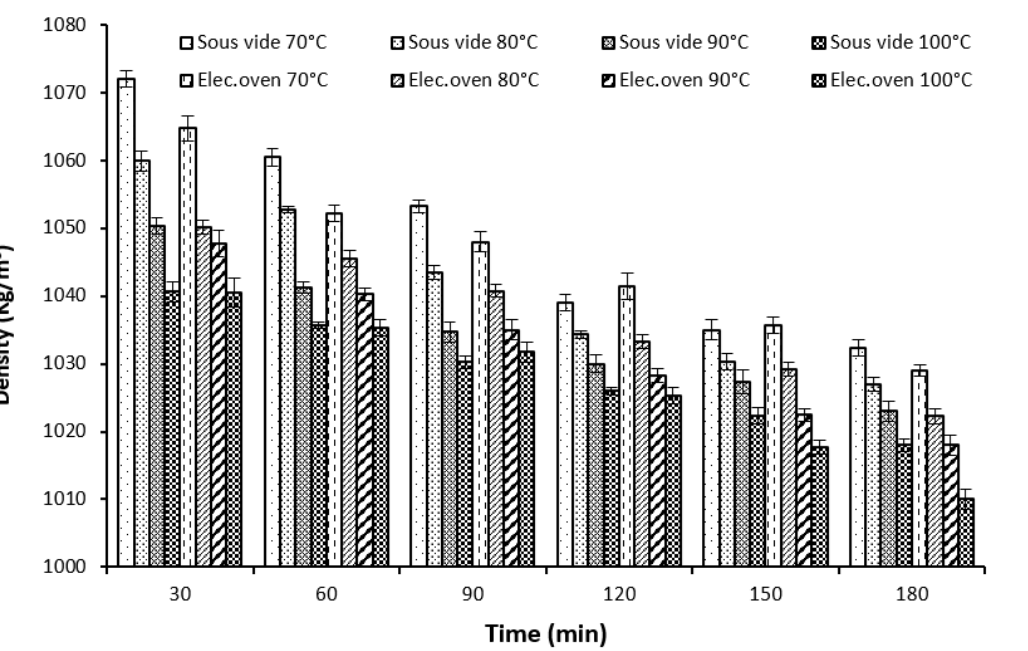
Figure 4. The effect of the cooking method (sous vide vs. electrical oven) on the camel meat physical properties (density) at different combinations of temperature and time .